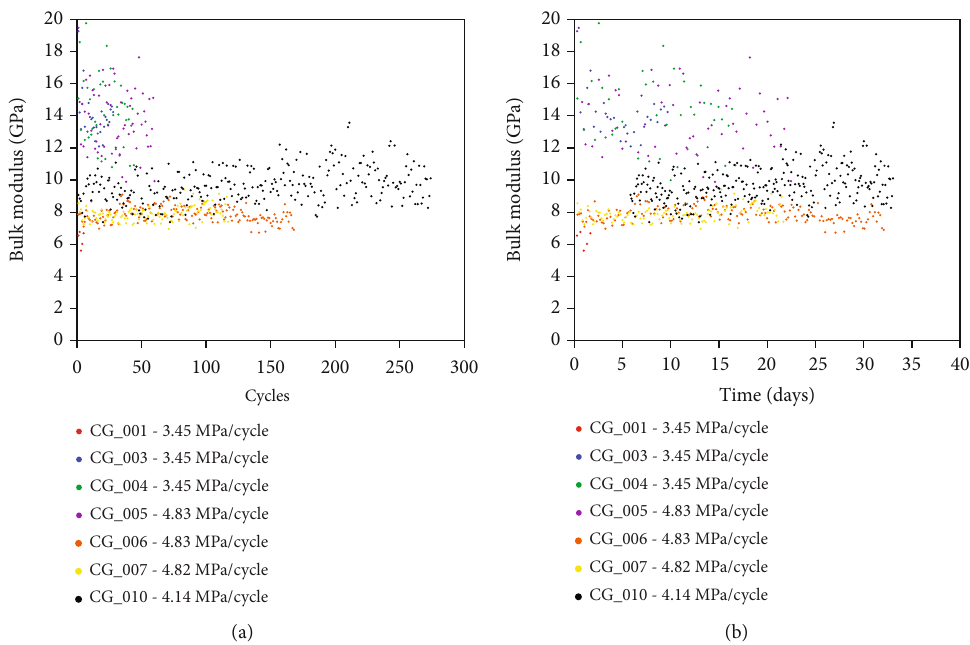
Figure 10: Evolution of unloading bulk moduli during hydrostatic stress cycling. Bulk modulus values are compared with the number of cycles (a) and the time elapsed